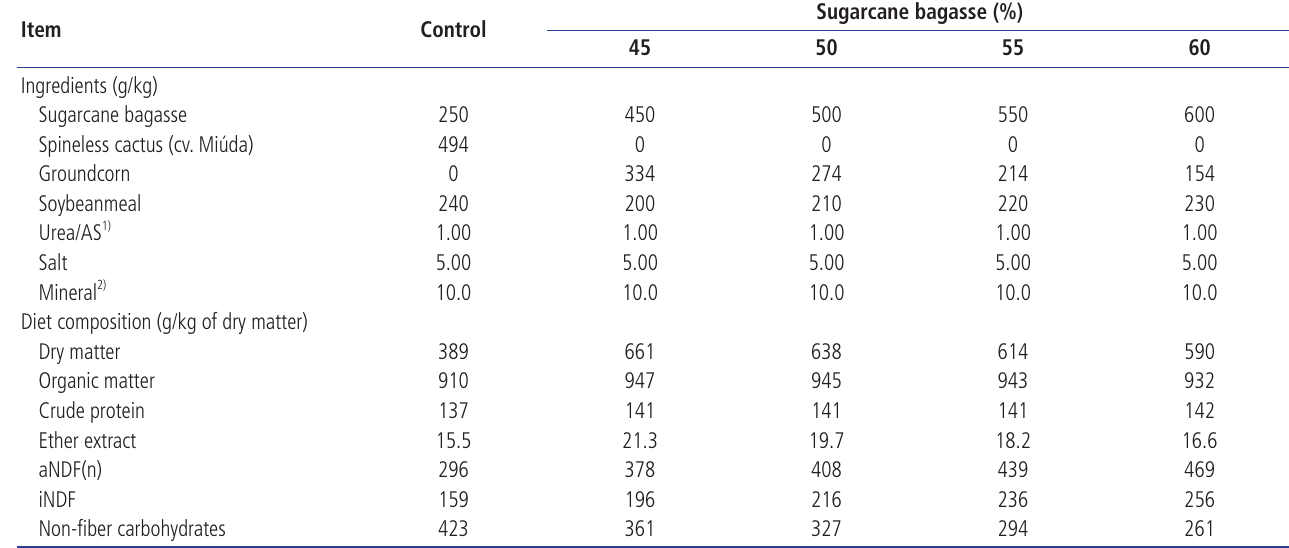
Table 2. Proportion of ingredients and chemical composition of the experimental diets